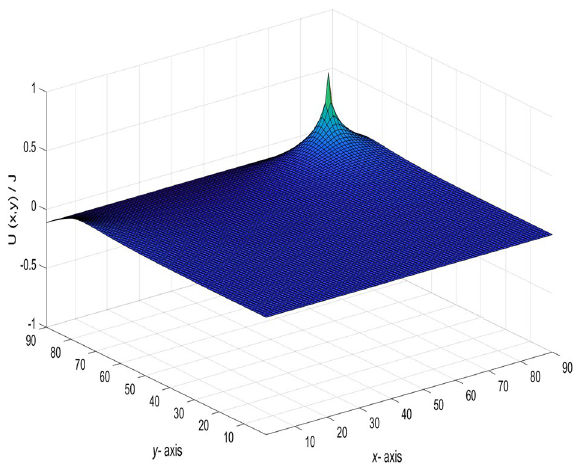
Figure 3. A 3D dynamic view for the changing graph of U 90